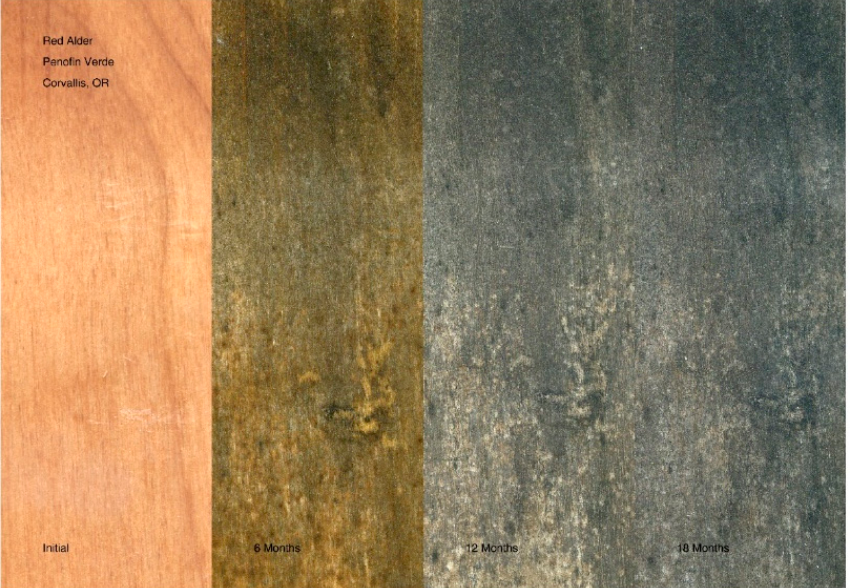
Figure 13. Example of the same red alder sample treated with Penofin Verde and exposed outdoors on a test fence near Corvallis, OR for 0, 6, 12, and 18 months (left to right).